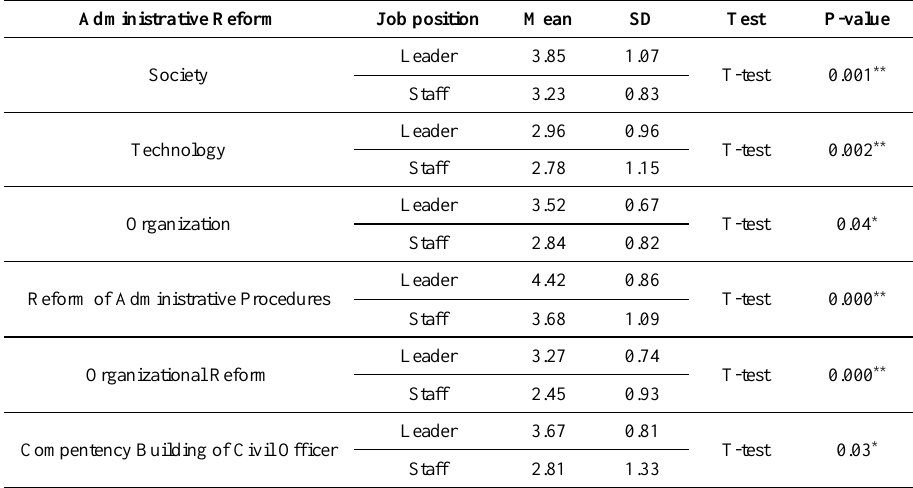
Table 7. Digital transformation and administrative reform under job position variables